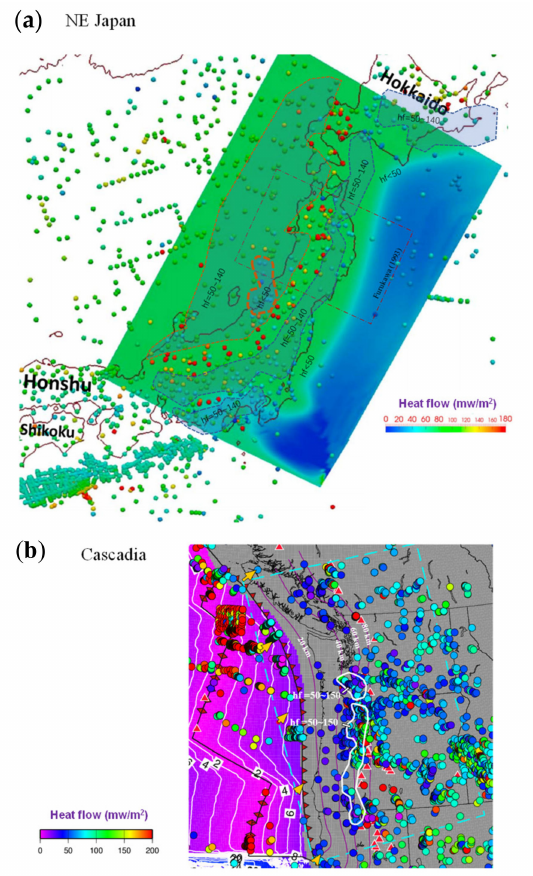
Figure 2. Integrated heat flow observations were based on the Global Heat Flow Database [19] and further combined with bottom-simulating reflectors [27,28], terrestrial boreholes, marine heat probes [29,30], and Hi-net boreholes [31]. The integrated observation of surface heat flow in NE Japan shows gradually changing values from the cold trench to the hot arc and then to the medium backarc. However, we found a forearc medium heat flow region (50–140/150 mW/m 2 ) in NE Japan and Cascadia, indicating that plate coupling occurs at a forearc depth of 40–80 km. The plate decoupling hypothesis is not robustly constrained by heat flow observations. ( a ) Northeast Japan. ( b )